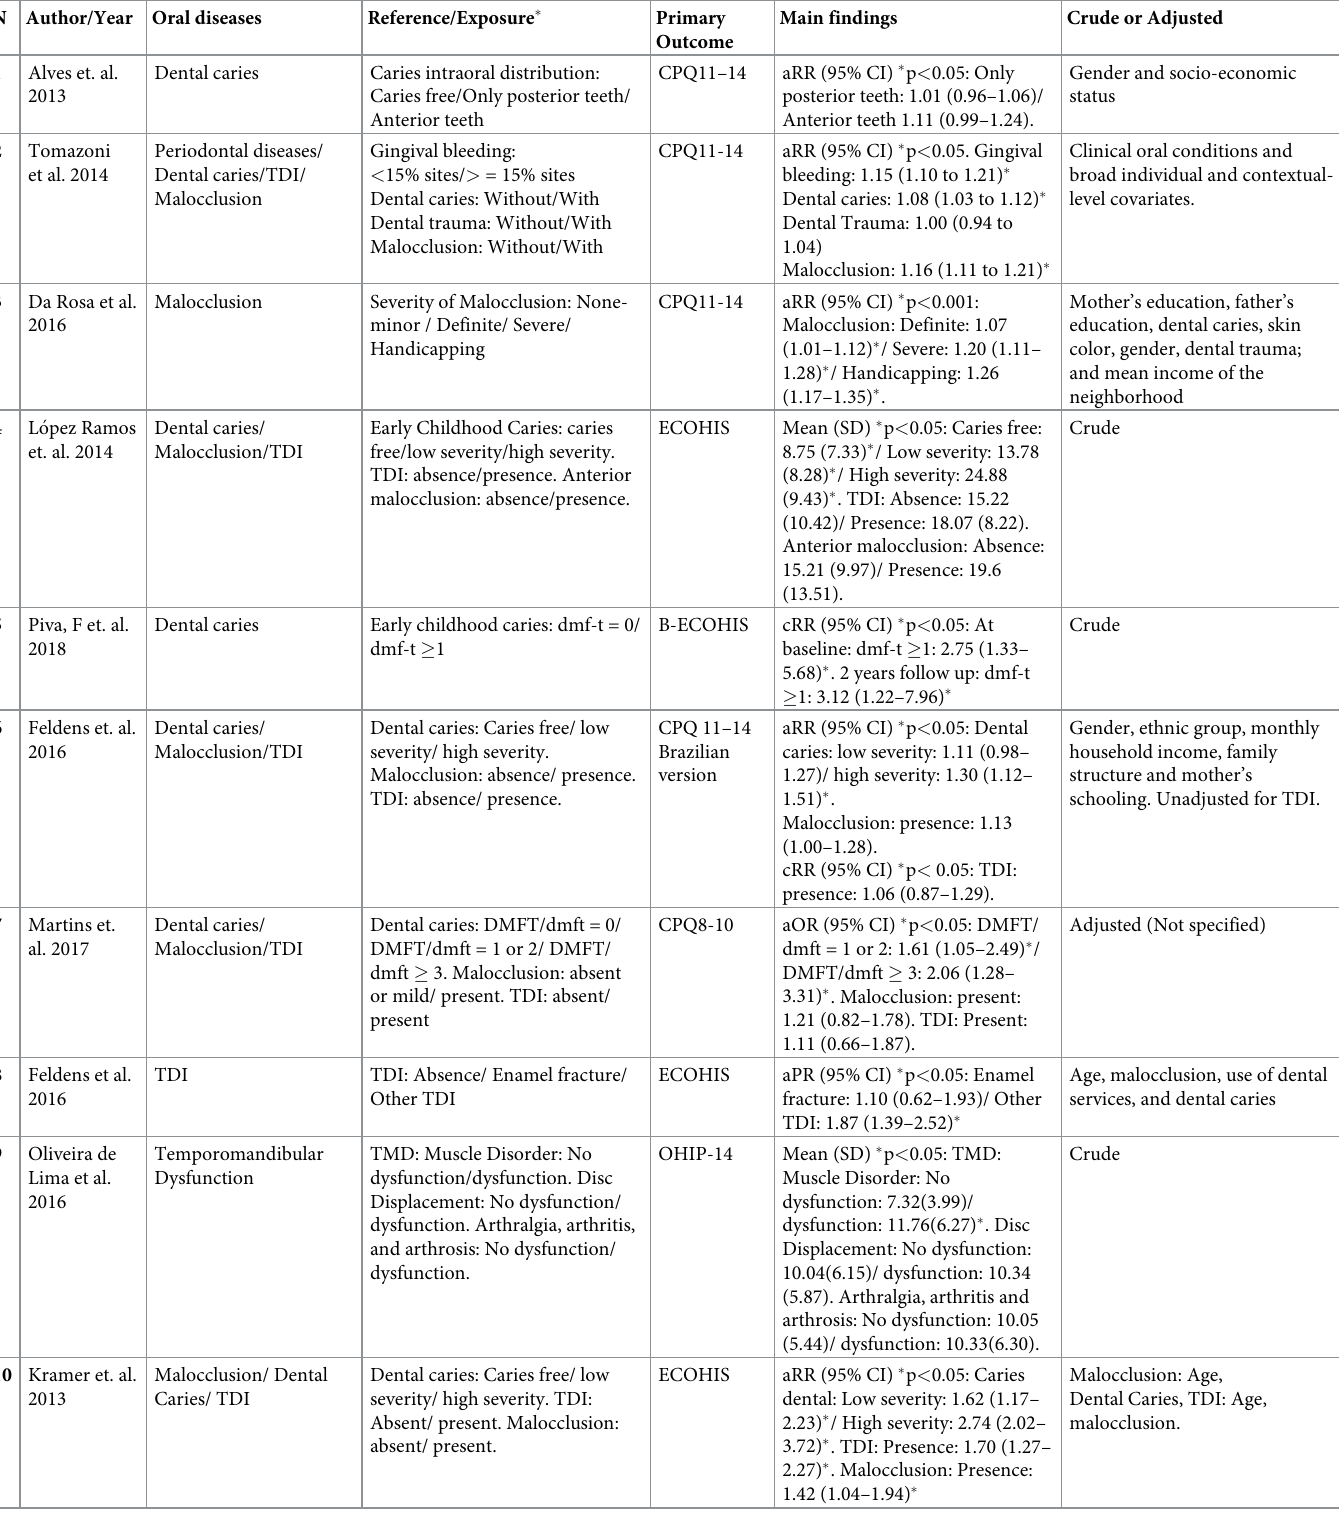
Table 2. Summary of results of the studies of different oral diseases and